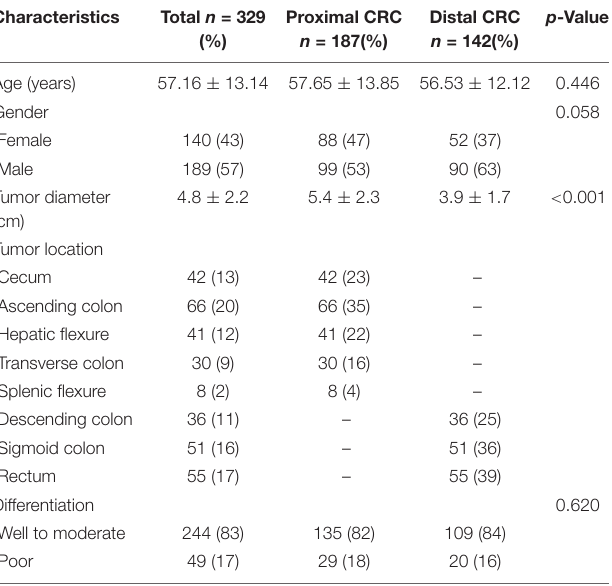
TABLE 1 | Clinical characteristics of patients with proximal and distal